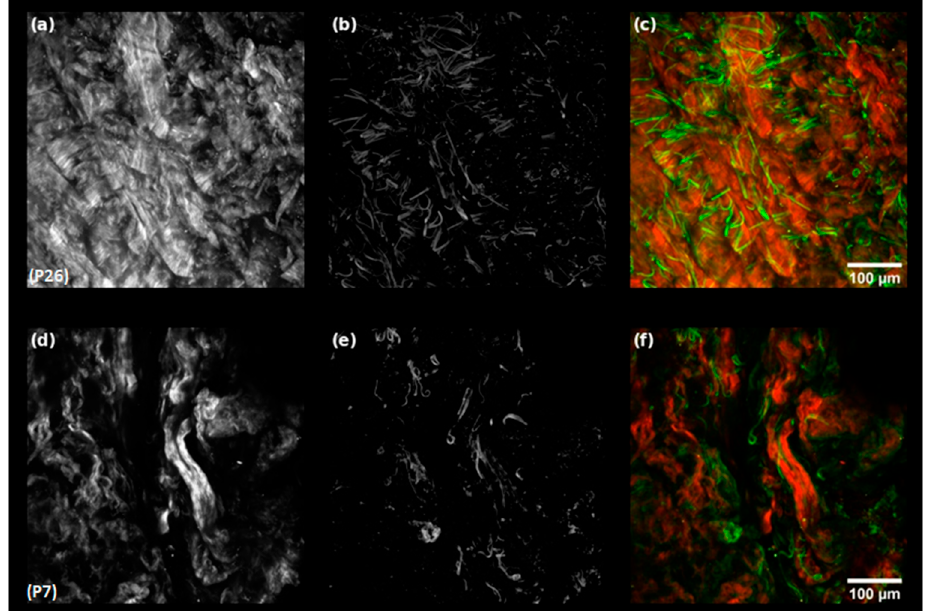
Figure 2. Representative multiphoton images of the dermis of cutaneous biopsies. Sample with lowest REC value (P26): ( a ) collagen fibres, ( b ) elastin fibres, and ( c ) false colour overlay image (red: collagen fibres; green: elastin fibres); Sample with highest REC value (P7): ( d ) collagen fibres, ( e ) elastin fibres, and ( f ) false colour overlay image (red: collagen fibres; green: elastin fibres).